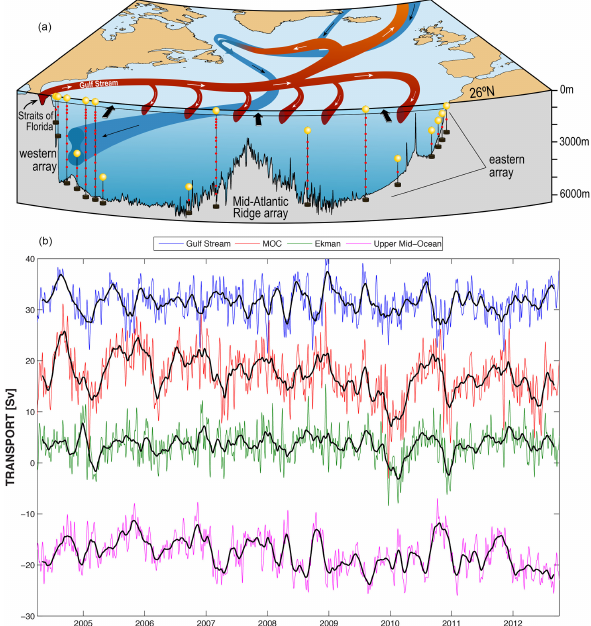
Figure 1. (a) Schematic of Rapid monitoring system for the Atlantic meridional overturning circulation (AMOC) at 26 ◦ N. (b) Rapid time series transports across 26 ◦ N since April 2004. Gulf Stream transport is derived from electromagnetic cable measurements in Florida Straits. Ekman transport is derived from ERA Interim wind estimates. Upper mid-ocean transport is derived from geostrophic velocity profiles from moored instruments across the Atlantic Ocean. The MOC transport is the sum of Gulf Stream, Ekman and upper mid-ocean transports. Black lines are 3-month low pass val- ues.